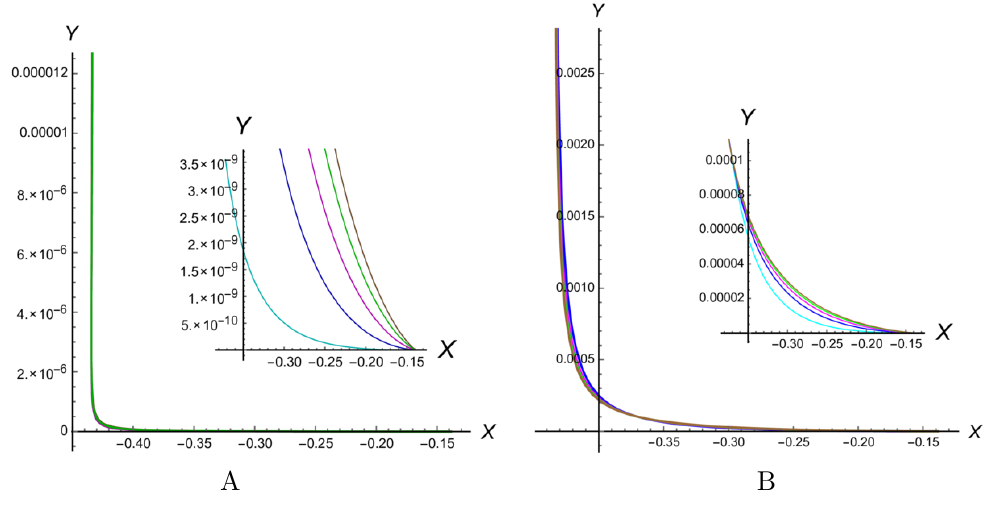
Figure 16 . RG (cid:13)ows in the ( X; Y )-plane in anisotropic case (cid:23) = 4 : 5 for (cid:22) = 0 (A) and (cid:22) = 0 : 5 (B); the plot legends are the same as in (cid:12)gure